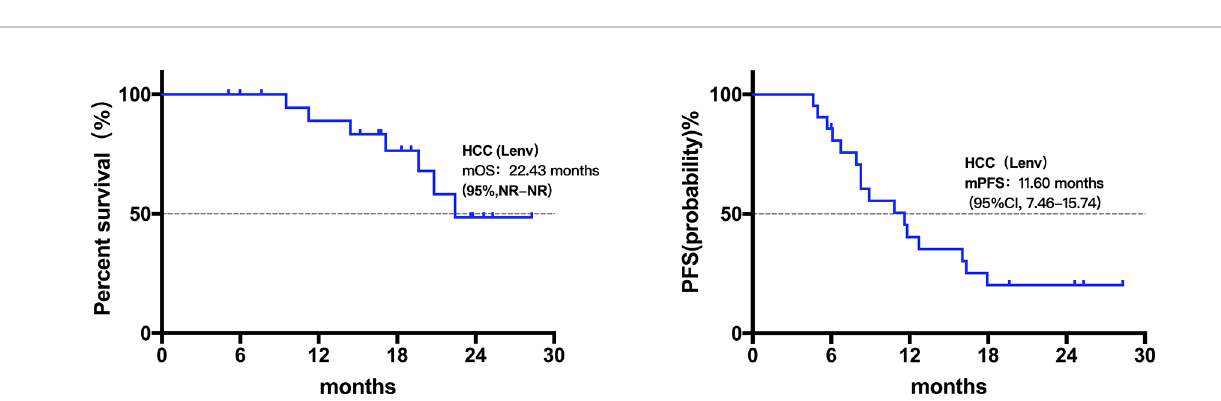
FIGURE 2 | Kaplan-Meier estimates of overall and progression-free survival in HCC patients treated with Lenvatinib monotherapy. The mOS of HCC patients treated with Lenvatinib only was 22.43 months (95% CI was not reached), the mPFS was 11.60 months (95% CI,